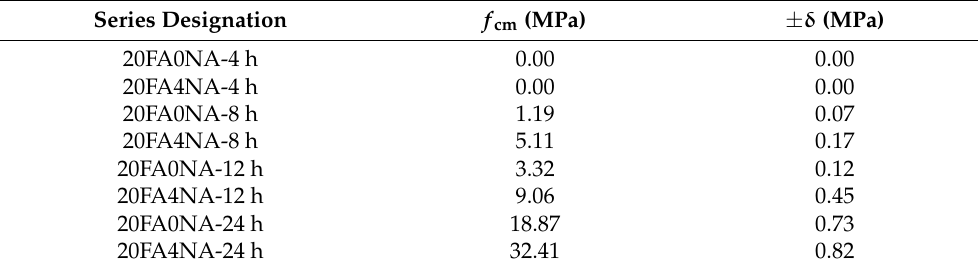
Table 7. Compressive strength test results— f cm .